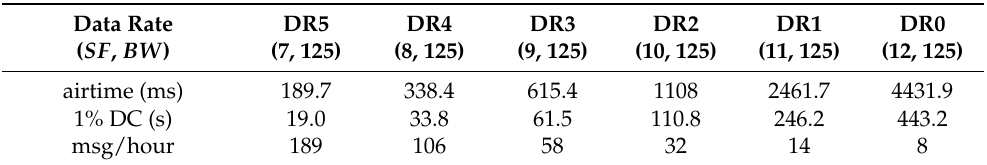
Table 5. Airtime and number of allowed messages according to different data rates for a payload of 100 bytes [27].